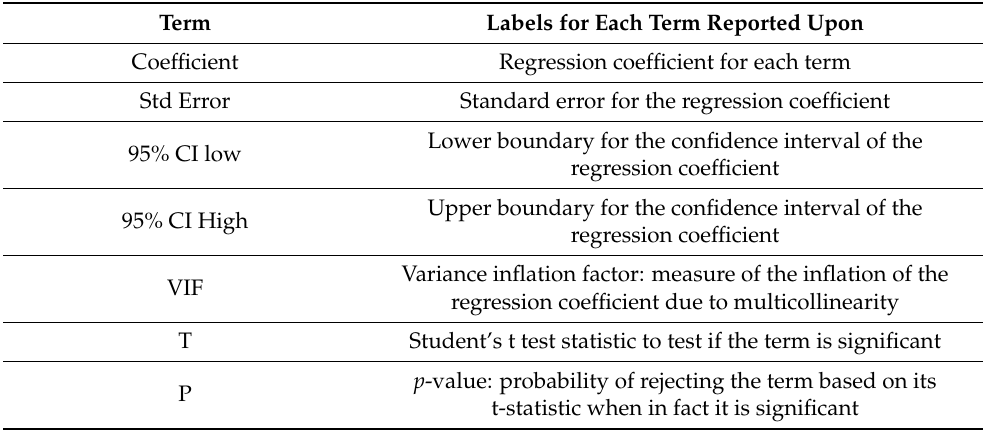
Table 1. Presentation of the main terms used in statistical analysis.